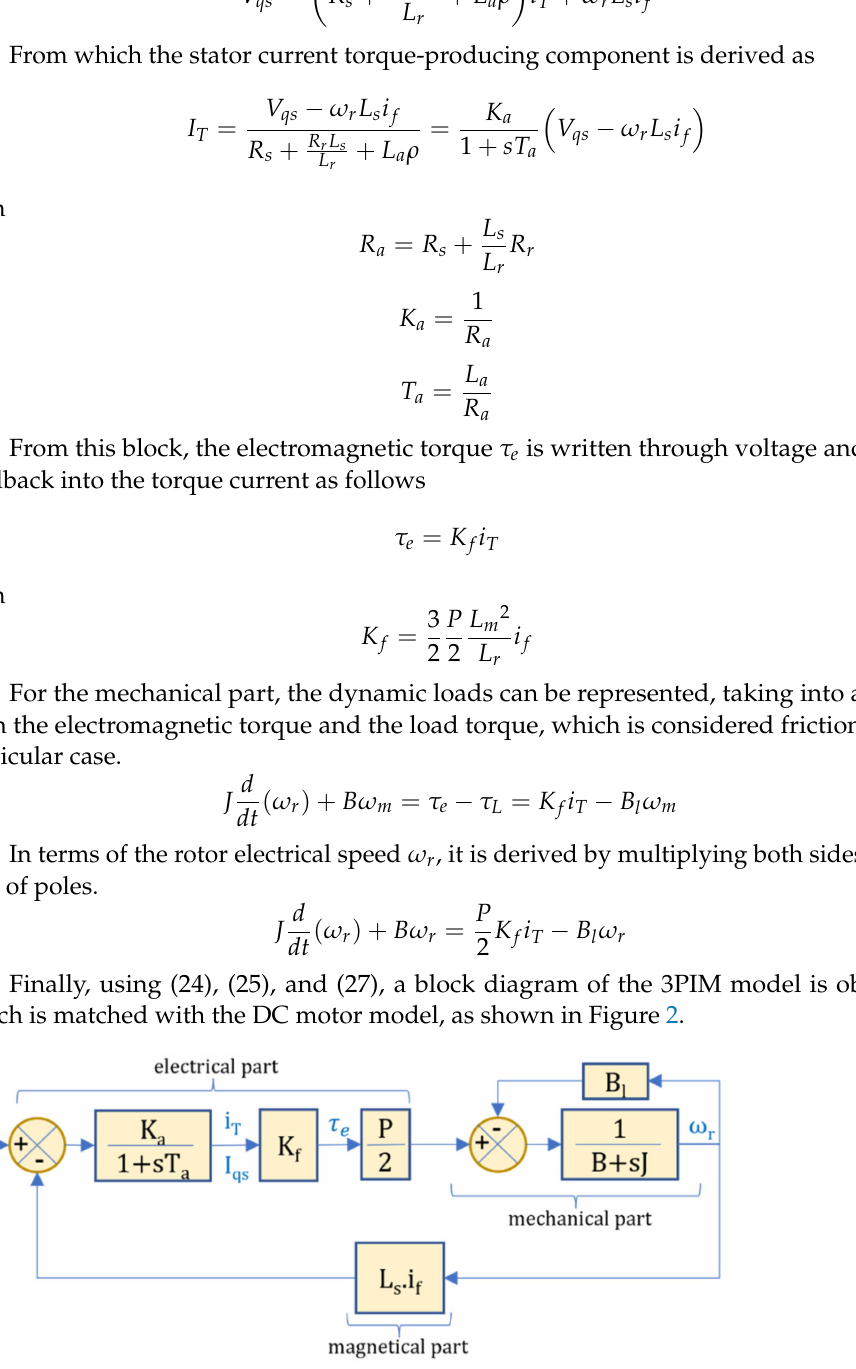
Figure 2. Block diagram of the 3PIM model matched with the DC motor